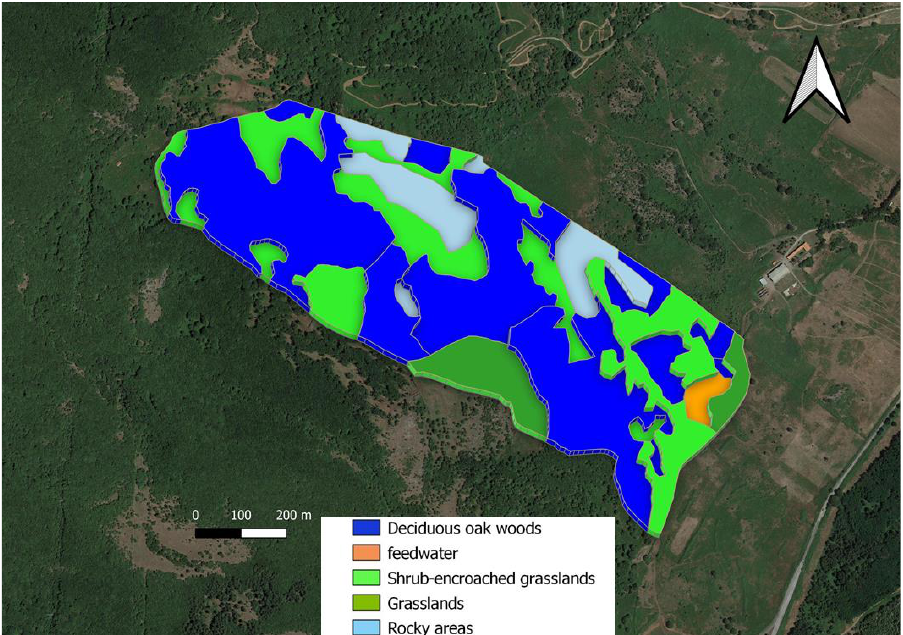
Figure 2. Map of experimental area. I. Deciduous oak woods, dark blue area; II. Shrub-encroached grasslands, bright green area; III. Grasslands, olive green area; IV. Feedwater, orange area; V. Rocky areas, light blue area. Table 2. Area and frequency of occurrence (% of the experimental area) of the three vegetation units (VUs), rocky areas and